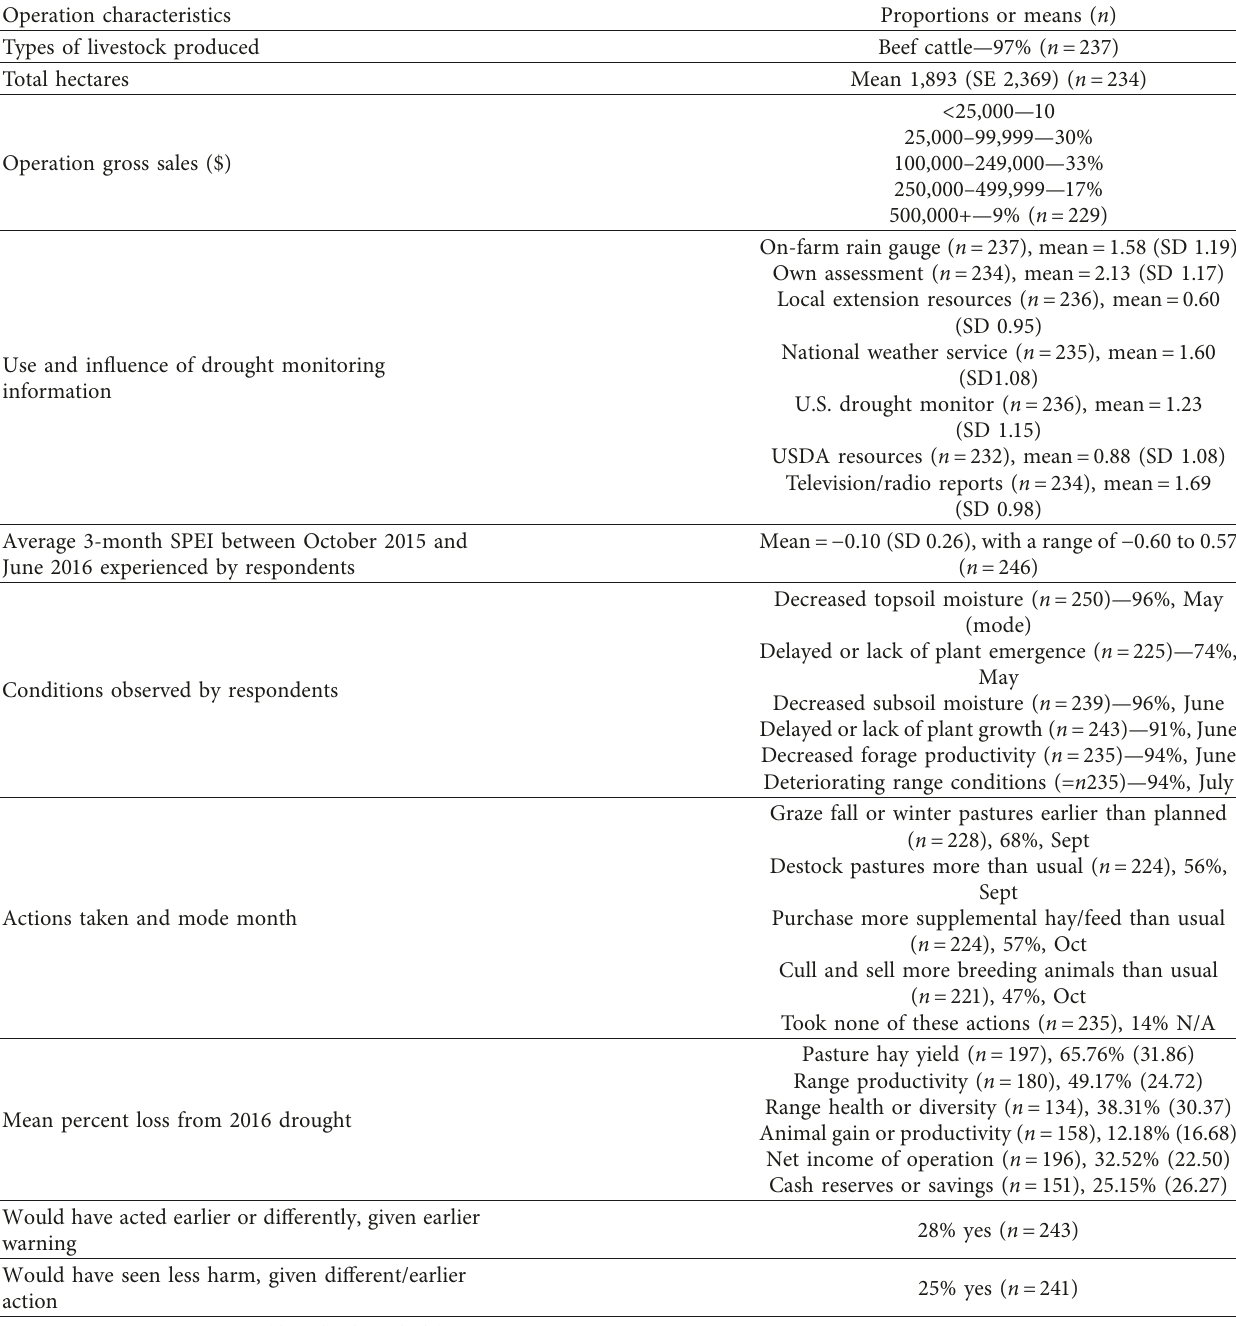
Table 1: Descriptive